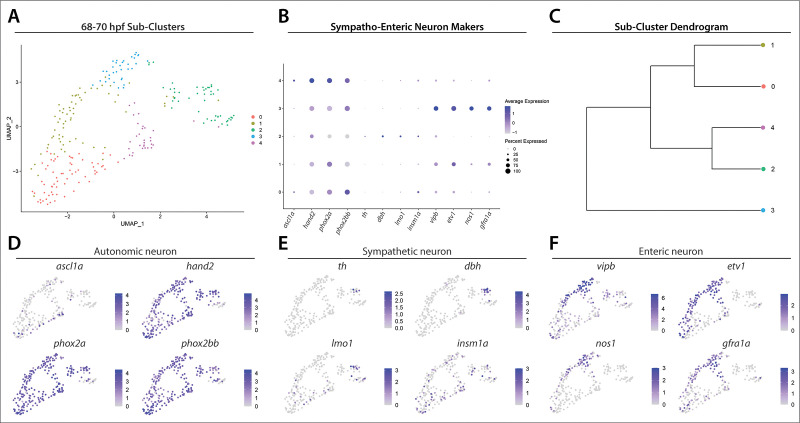
Enteric and sympathetic neuron markers distinguished among common autonomic neuron precursors.UMAP analysis of Sub-clusters depicts enteric and sympathetic neurons delineating from a common pool of autonomic neurons. (A) UMAP plot generated following re-clustering of Clusters 5 and 12 from the 68–70 hpf data set. (B) Dot plot depicts expression levels of general autonomic neuron makers (ascl1a, hand2, phox2a, phox2bb), sympathetic neuron markers (th, dbh, lmo1, insm1a) and enteric neuron markers (vipb, etv1, nos1, gfra1a) within Sub-clusters 0–4. (C) Dendrogram denotes similarity of Sub-clusters based on average gene expression of each cell within the Sub-clusters, which reveals transcriptomic distinction of enteric neuron Sub-cluster 3. (D–F). Feature plots highlight the expression of autonomic, sympathetic, and enteric neuron gene markers within UMAP Sub-clusters.